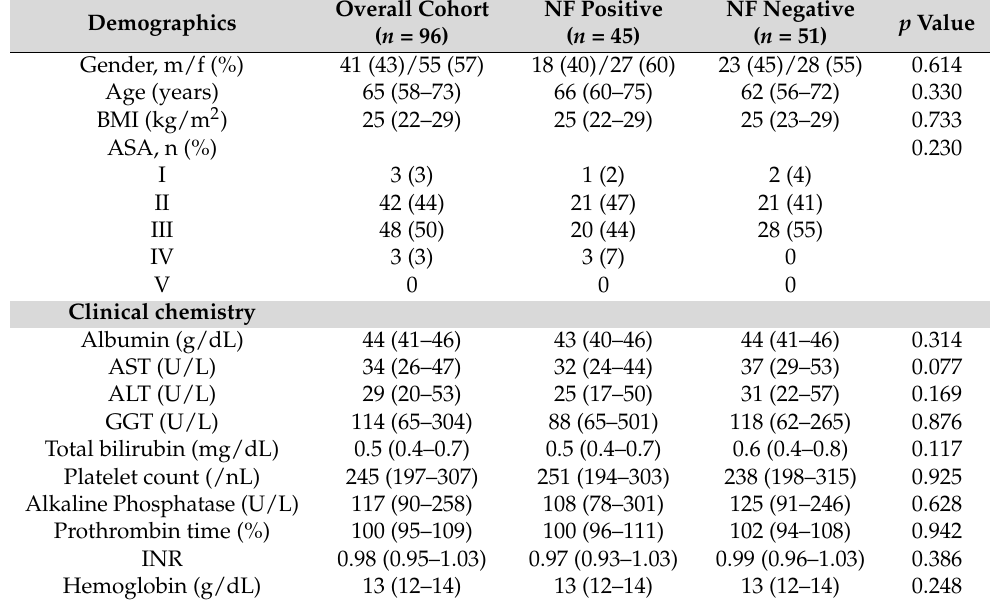
Table 1. Patients’ characteristics. Data presented as median and interquartile range if not noted otherwise. ALT, alanine aminotransferase; ASA, American society of anesthesiologists classification; AST, aspartate aminotransferase; BMI, body mass index; CSS, cancer-specific survival; GGT, gamma glutamyltransferase; INR, international normalized ratio; LVI, lympho-vascular invasion; MVI, microvascular invasion; NF, nerve fibers; PNI, perineural invasion, RFS, disease-free survival.